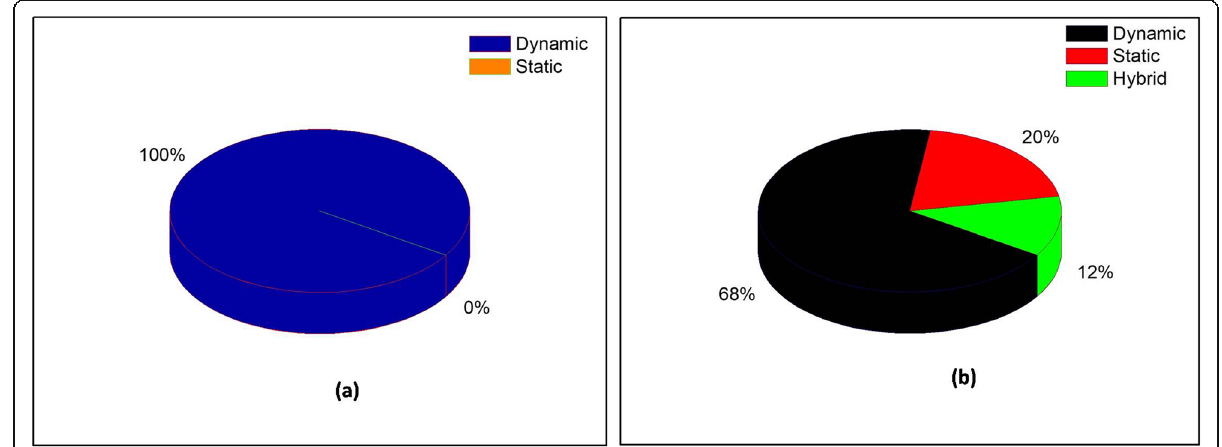
Fig. 9 Percentage based on state of algorithm in proactive (dynamic and static)and reactive (dynamic, static, and hybrid) approaches